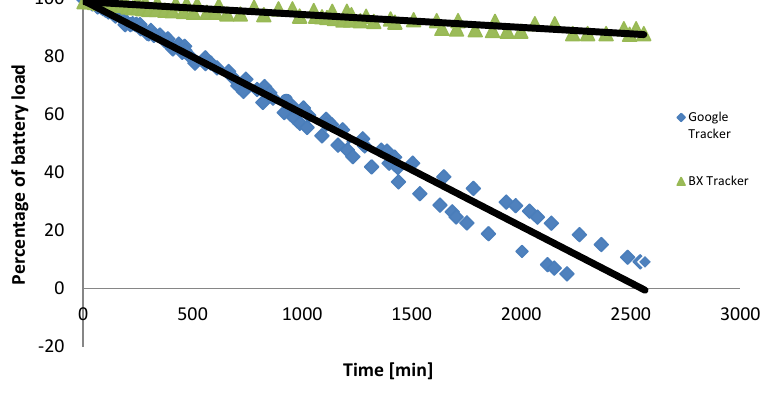
Figure 7. Comparison of battery use for BX Tracker and Google